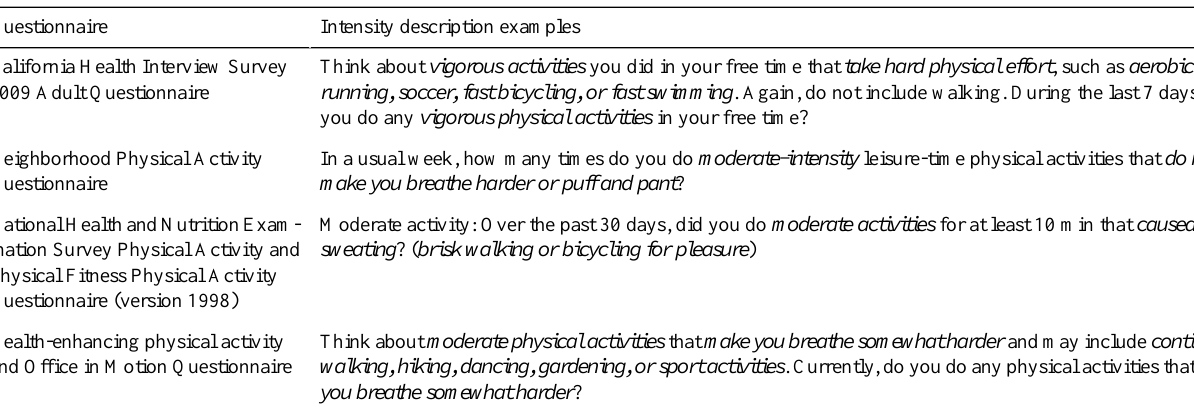
Table 1. Activity intensity descriptions used in various physical activity questionnaires. Intensity description